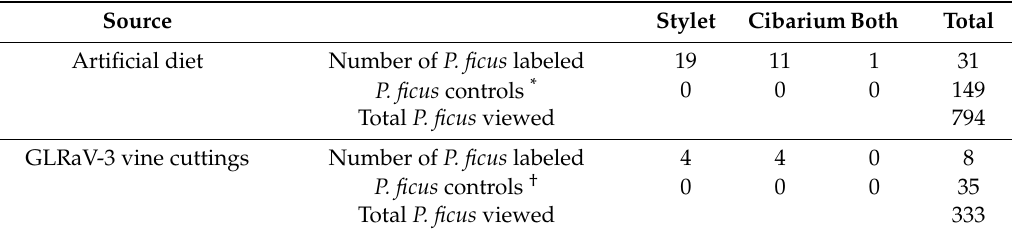
Table 3. GLRaV-3-transmission is reduced by a lectin. a) Results from three biologic replicates of GLRaV-3 blocking transmission tests showing the number of plants infected/plants inoculated. b)